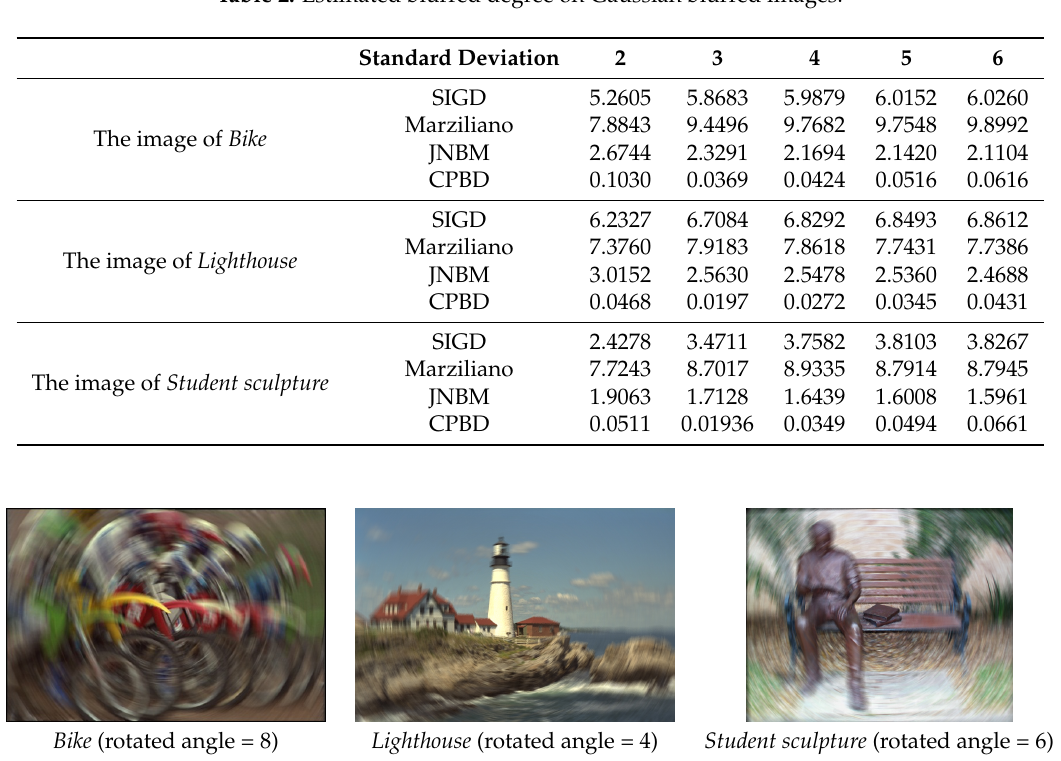
Figure 4. Three gaussian motion blurred images used in our experiments. Table 2. Estimated blurred degree on Gaussian blurred images.